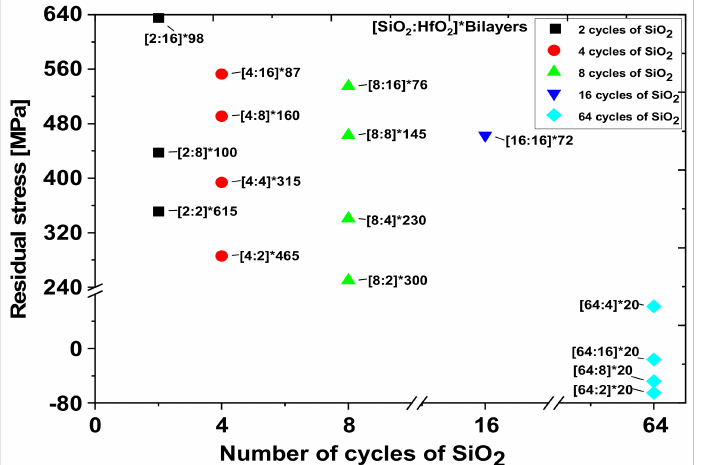
Figure 8. Residual stress values of the SiO 2 :HfO 2 heterostructure coatings.